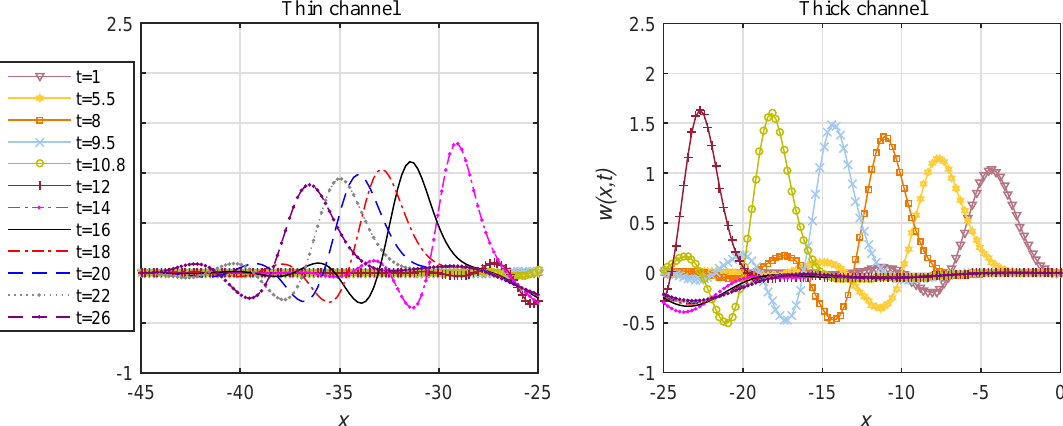
Figure 7. The experiment with α 2 = 4 α 1 ( a = 1/8, b = 1/2, c = 1); the time ranges from t = 1 to